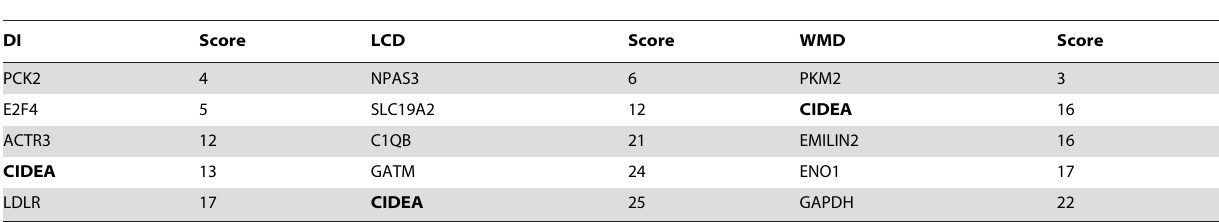
DI, dietary intervention; LCD, low calorie diet; WMD, weight maintenance diet. Score is the mean of the ranking from sparse Partial Least Square Discriminant Analysis and Random Forests based on Variable Influence on Projection and Mean Decreased Gini, respectively. Bold indicate genes with correlation independent from change in body mass index (n=216).